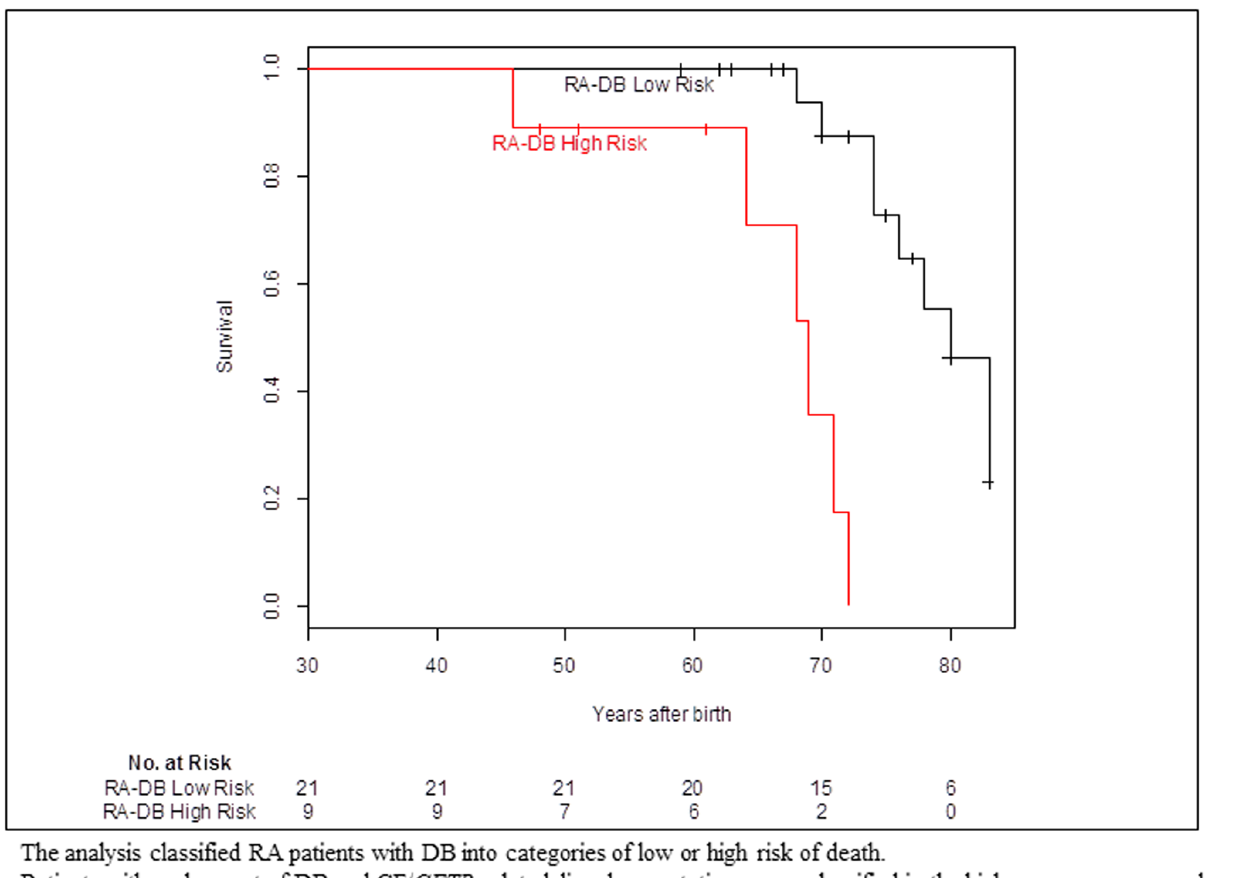
Figure 3. Kaplan-Meier probability of survival from birth of patients with both RA and DB according to risk of death categories. The analysis classified RA patients with DB into categories of low or high risk of death. Patients with early onset of DB and CF/ CFTR -related disorders mutations were classified in the high group as compared with the other patients with both RA and DB who were classified into the low risk. RA: rheumatoid arthritis; DB: diffuse bronchiectasis. Early-onset DB: respiratory symptoms preceding RA by . 10 years (mostly childhood DB). Late-onset DB: respiratory symptoms occurring at the same time or , 10 years before RA onset (adulthood DB). Mutations: cystic fibrosis (CF) and cystic fibrosis transmembrane conductance regulator ( CFTR )-related disorder mutations. See Patients and Methods for additional